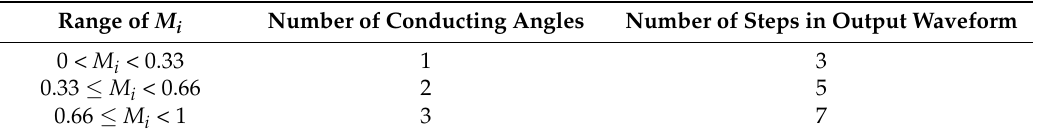
Table 4. Number of conducting angles and steps in output waveform SPWCAD technique for various M i .